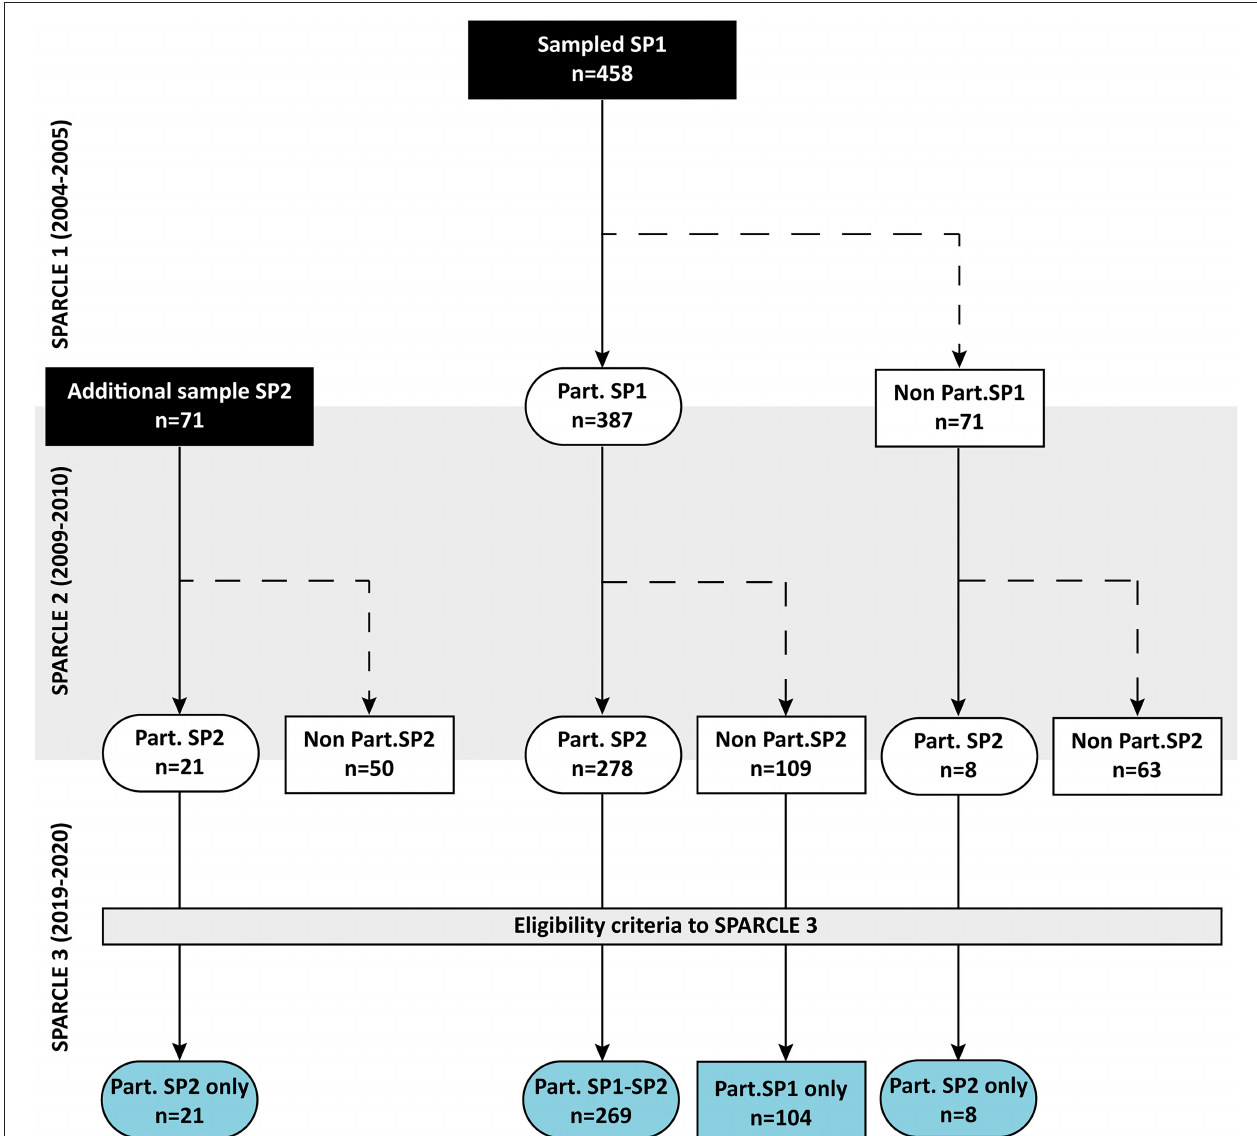
FIGURE 1 | Recruitment process and participation of individuals with CP—SPARCLE cohort—France, Germany, Italy, Sweden. Part, Participants; SP, SPARCLE.